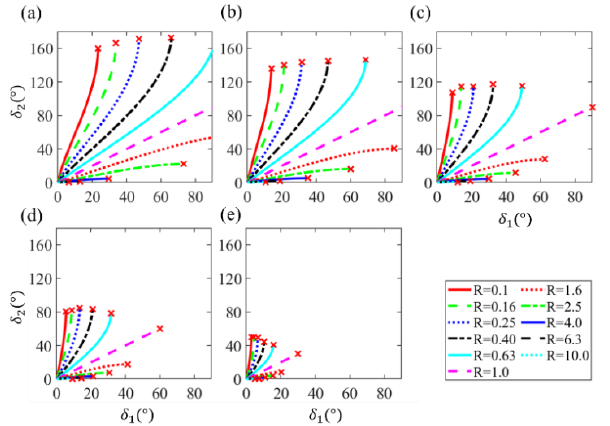
Figure 7. Effect of h 1 on angle magnification in a single four-bar linkage finger structure: ( a ) h 1 = 0.2 L ,